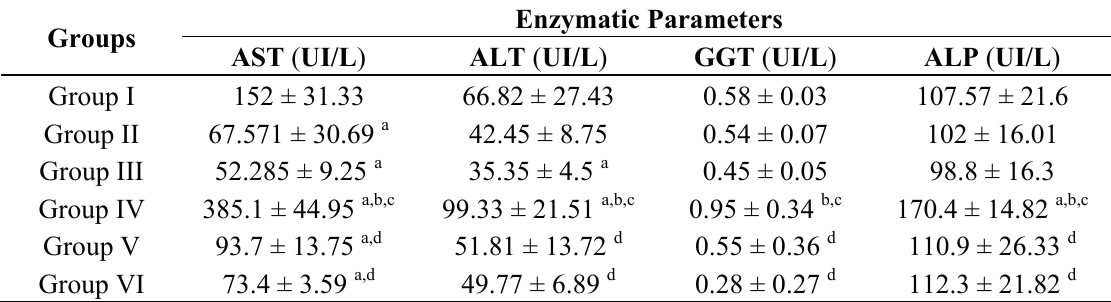
Table 3. Enzymatic profile results.